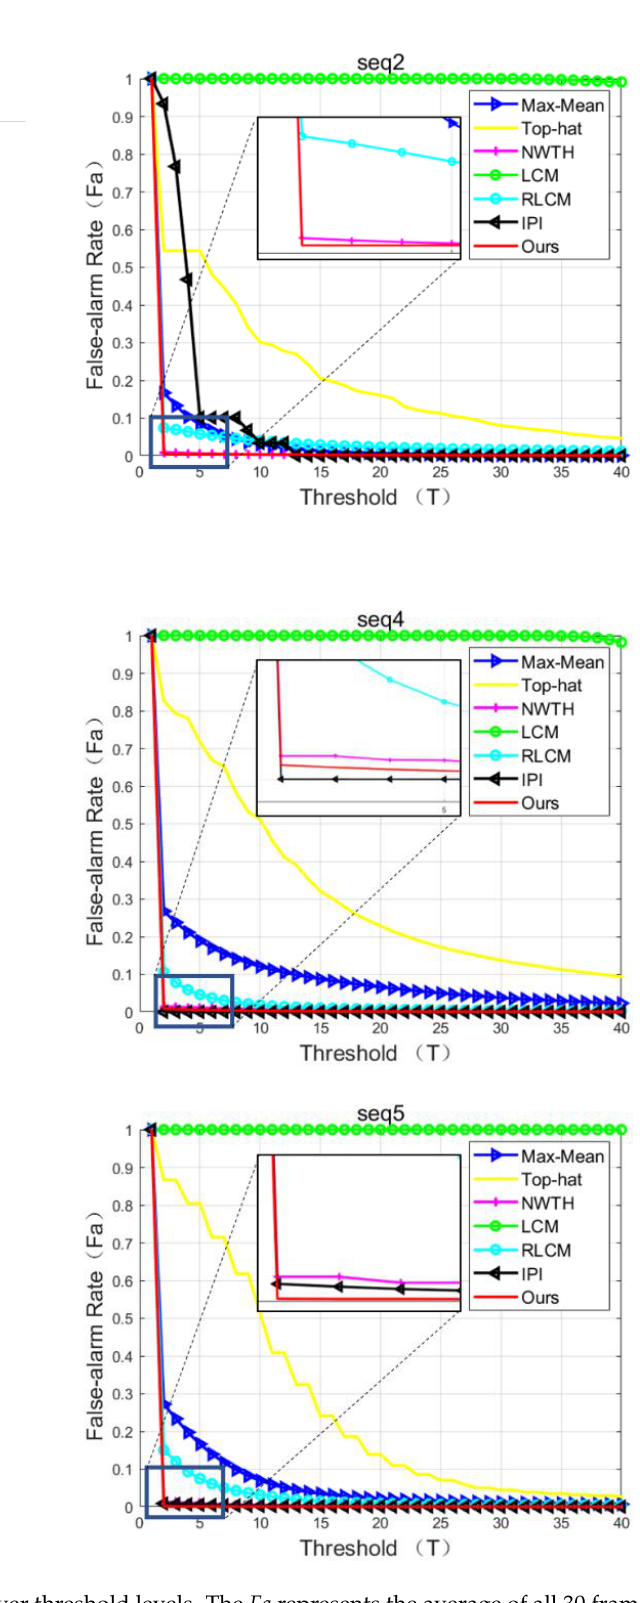
Figure 11. False alarm rates over threshold levels. The Fa represents the average of all 30 frames of that sequence.